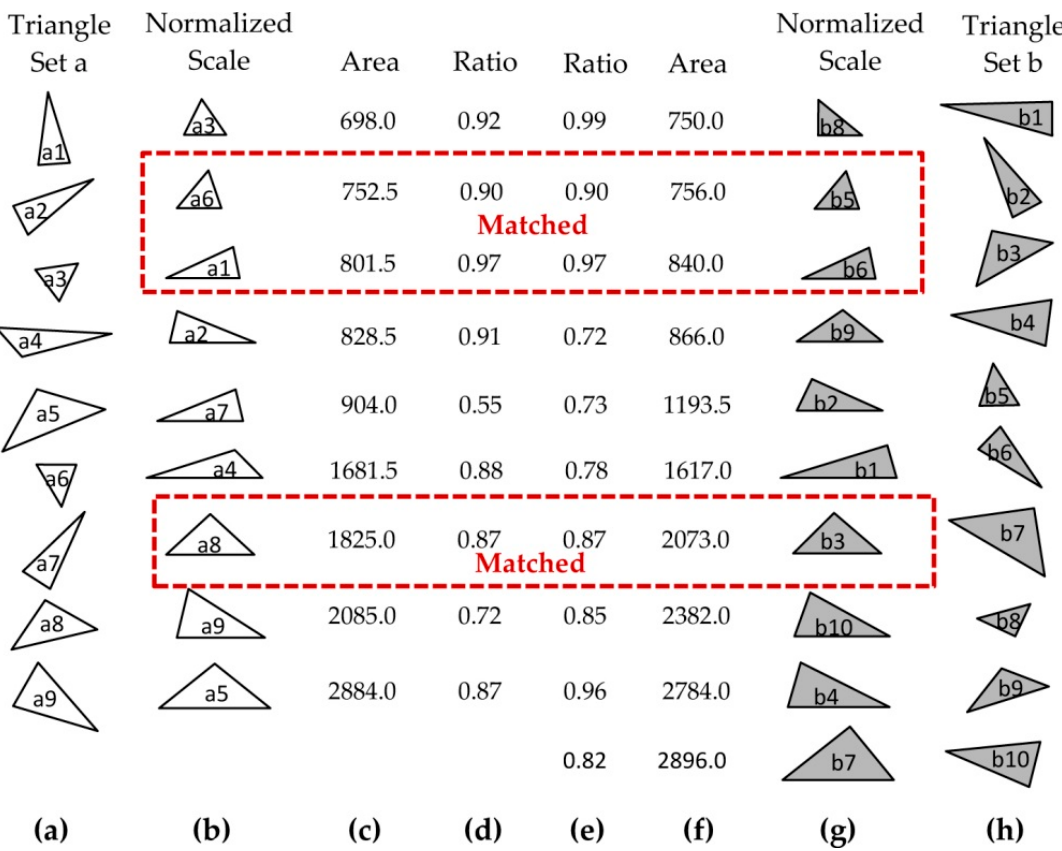
Figure 18. Matching in the case of affine transformation. ( a ) Set of triangles of vein minutiae from the template. ( b ) Sorted ( a ) in ascending order. ( c ) The area of ( b ). ( d ) Ratio of the area of ( c ). ( h ) Set of triangles of vein minutiae from the query. ( g ) Sorted ( h ) in ascending order. ( f ) The area of ( g ). ( e ) Ratio of the area of ( f ). Matching triangles between ( d ) and ( e ) are shown in the box.